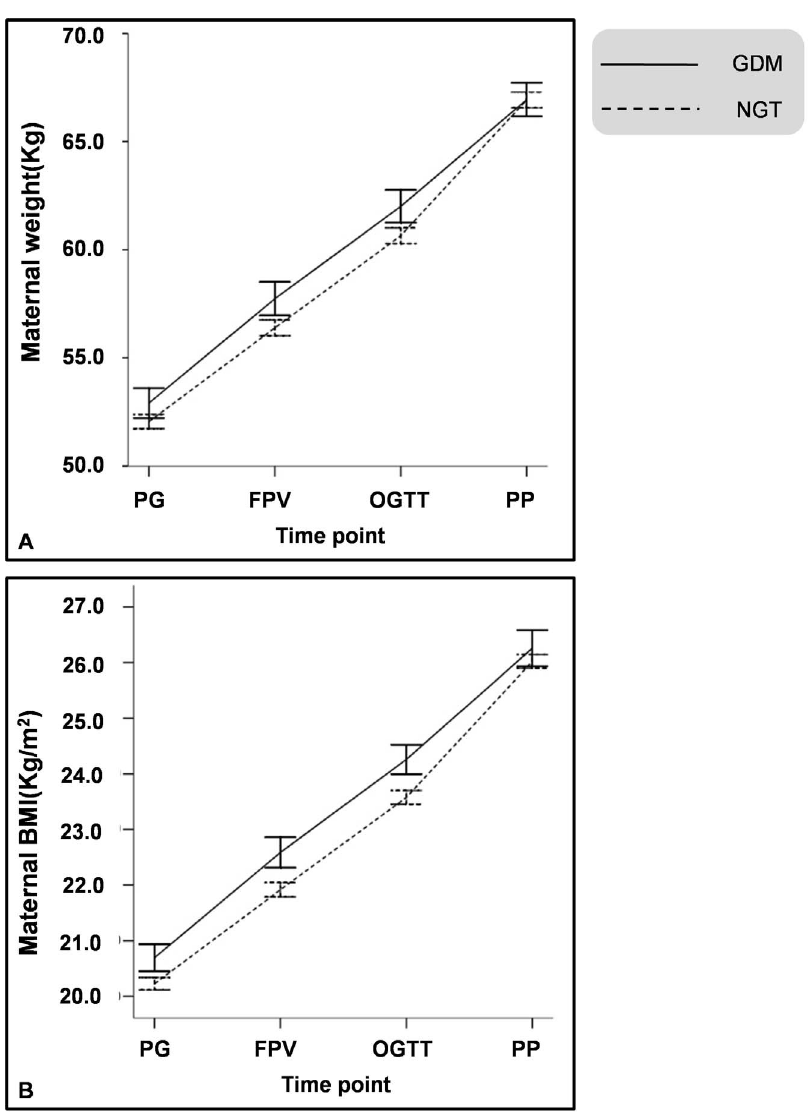
Fig. 1. Weight and BMI changes in pregnant women complicated with GDM and control (NGT) groups during pregnancy. Panel A. Weight and weight gain in GDM and NGT groups before pregnancy (Pregravid, PG), at first prenatal visit (FPV), at OGTT time (OGTT), and before delivery (Prepartum, PP). Panel B. BMI of GDM and NGT group before pregnancy (Pregravid, PG), at first prenatal visit (FPV), at OGTT time (OGTT), and before delivery (Prepartum,